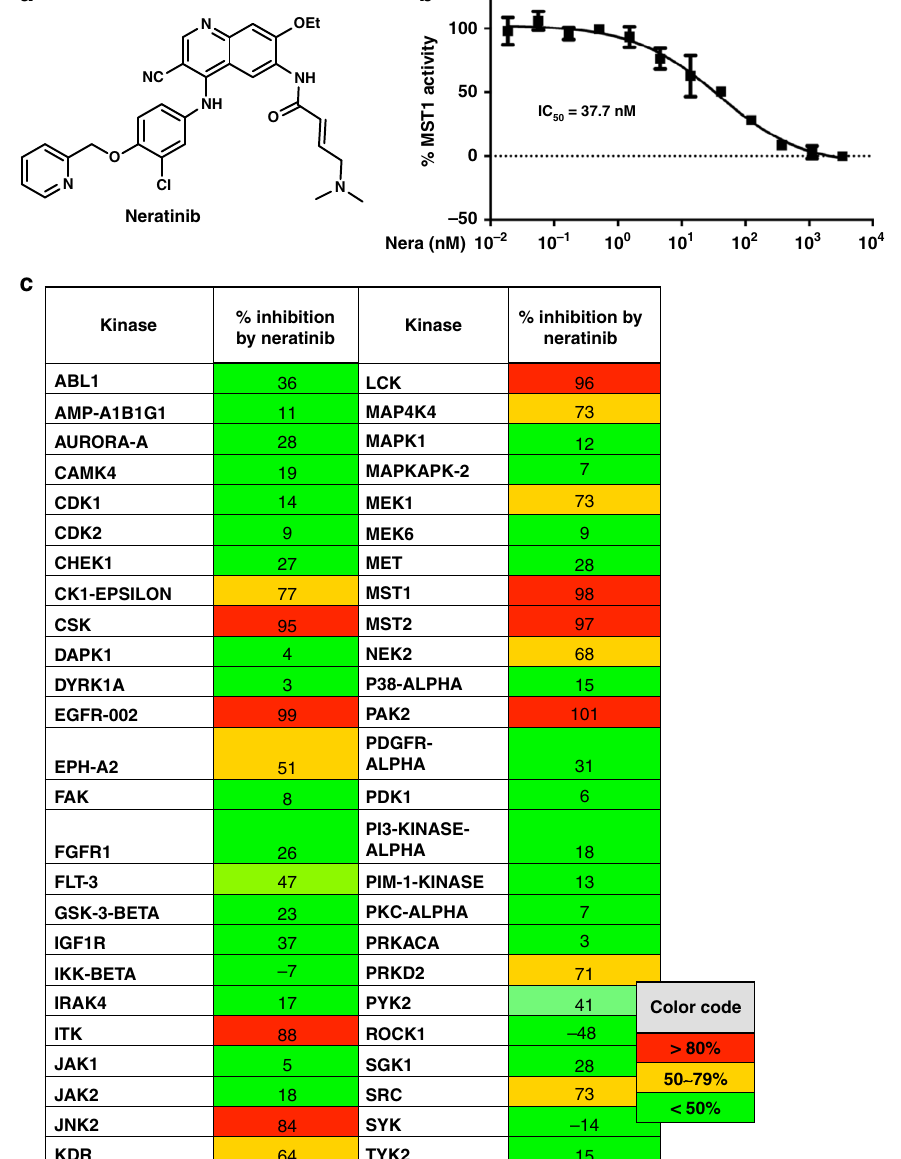
Fig. 1 Neratinib, a kinase inhibitor with MST1 ef fi cacy. a Chemical structure of neratinb. b Biochemical dose response con fi rmation of MST1 inhibition. Data show means ± SEM from three independent experiments ( n = 3). c Kinase pro fi ling showing % kinase inhibition at 10 µ M neratinib with a panel of 50 kinases, means of duplicates are shown. Source data for ( b ) are provided as a Source Data fi